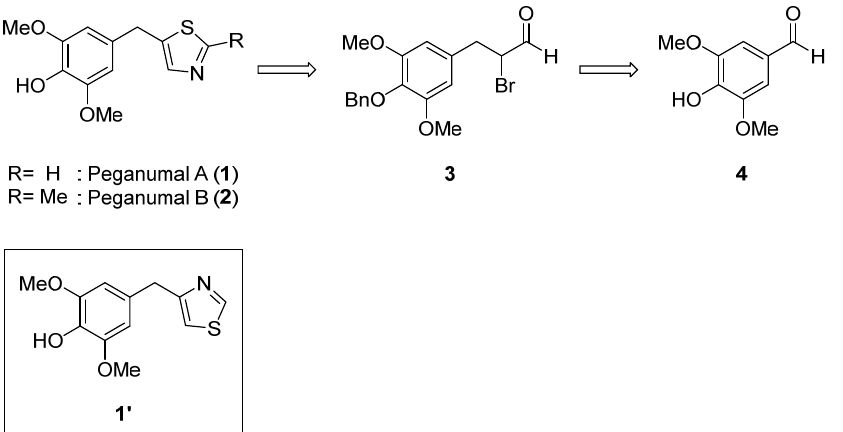
Figure 1. Structure and retrosynthetic analysis of peganumal A ( 1 ) and B ( 2 ), and the possible regioisomer of peganumal A ( 1 ′ ).